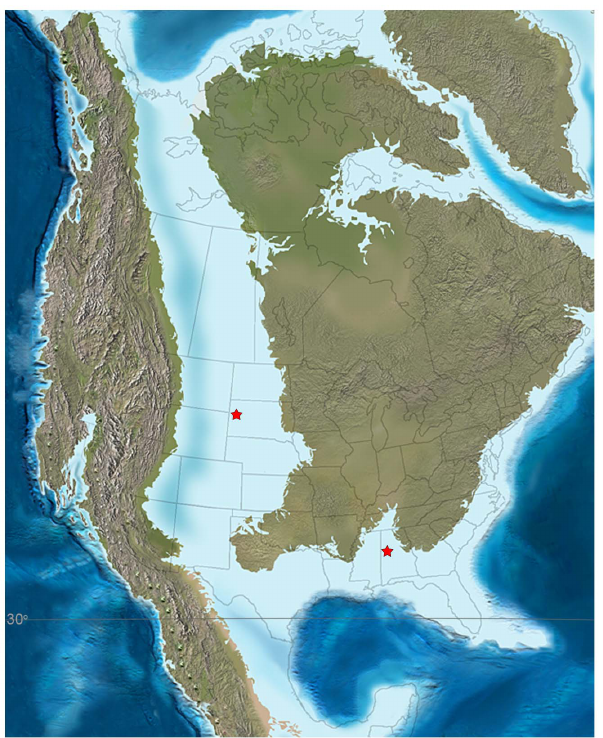
Figure 2. Paleomap of North America during the Late Cretaceous (85Ma, from Blakey, 2011). Fossil localities in South Dakota and Alabama are indicated by red stars. The locality in South Dakota was within the Western Interior Seaway, while the locality in Alabama was on the Gulf Coast. The paleolatitude has been estimated from Smith et al. [34].